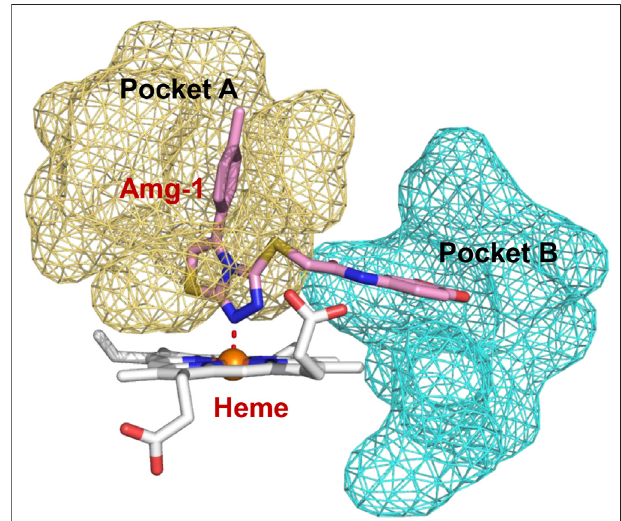
FIGURE 6 | Co-crystallized structure of IDO1/Amg-1 (pink) complex (PDB: 4PK5). Pocket A is represented by an yellow surface and pocket B is represented by a cyan